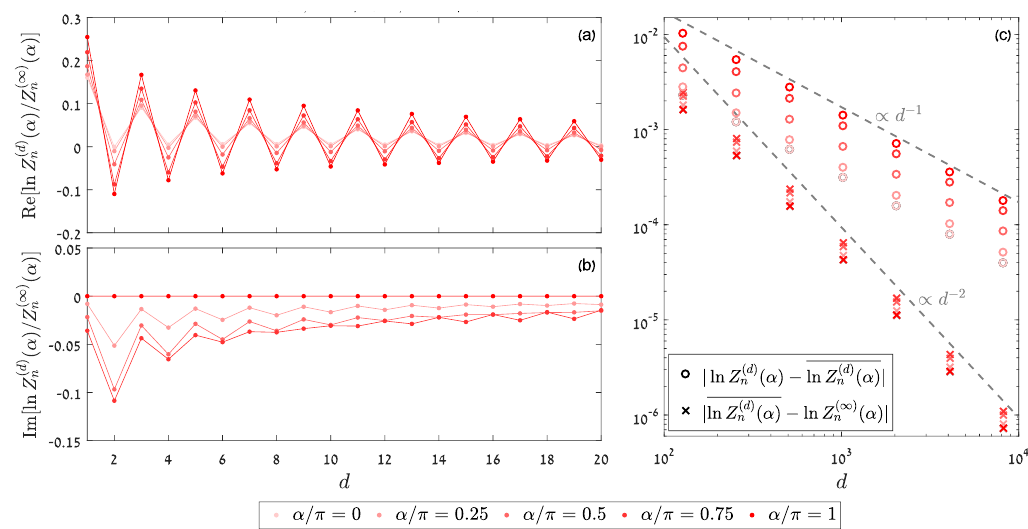
( α ) , the distance- Figure 7: The single impurity model: The deviation of ln Z ( d ) n dependent generating function calculated numerically using Eqs. (13) and (21) (where d is the distance between the leftmost site of A and the origin, at which ( α ) , the generating function for d → ∞ cal- the scatterer is located), from ln Z ( ∞ ) n culated numerically using Eqs. (17) and (21), in a subsystem of L = 100 sites. Re- = t , k = π/ 2 and sults are shown for various fixed values of α , with n = 2, ε F , R 0 = 2 π/ 3. Both (a) the real part and (b) the imaginary part of the deviation are k F , L plotted (dots), accompanied by thin lines as guides to the eye (note that for α = 0 the imaginary part vanishes by definition). Panel (c) shows the deviation for d > L following averaging over oscillations, where the absolute values of both the average ( d ) ( α ) − ln Z ( ∞ ) ( α ) and the amplitude ln Z ( d ) ( α ) − ln Z ( d ) ( α ) of the oscillations ln Z n n n n are plotted. Dashed gray lines emphasize that for all plotted values of α , the average deviation approaches a ∝ d − 2 power law behavior and the amplitude approaches a ∝ d − 1 power law